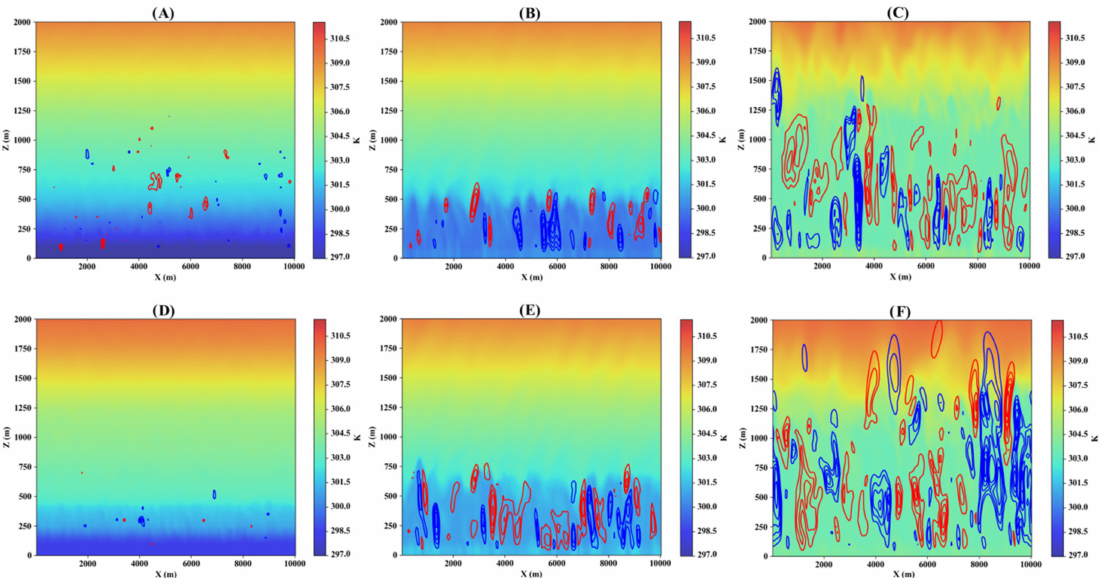
Figure 5. Plane x – z ( y = 5.0 km) of potential temperature (K) and vertical wind contours (m s − 1 ), colors (line) representing upward (blue) and downward (red) movements, at different times of the day for ( A – C ) IOP 1 and ( D – F ) IOP 2, where the local time is ( A , D ) 04 LT, ( B , E ) 08 LT, and ( C , F ) 10